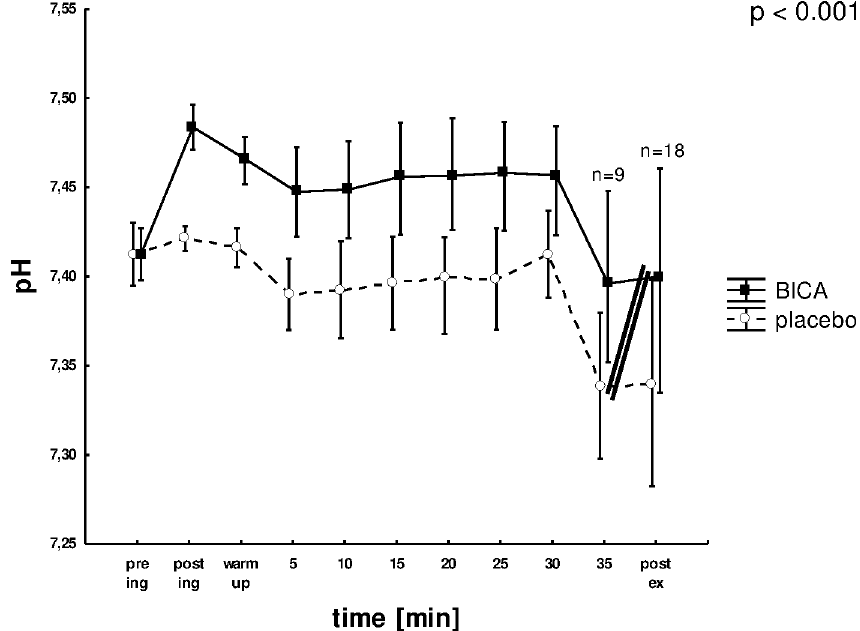
Fig 3. pH prior (pre ing), after ingestion (post ing), during the constant load test and post exercise (post ex) for BICA (closed squares) and placebo (open circles). Doublebar indicatesend of exercise. Data are expressedas means ± SD. p = interaction between conditionand